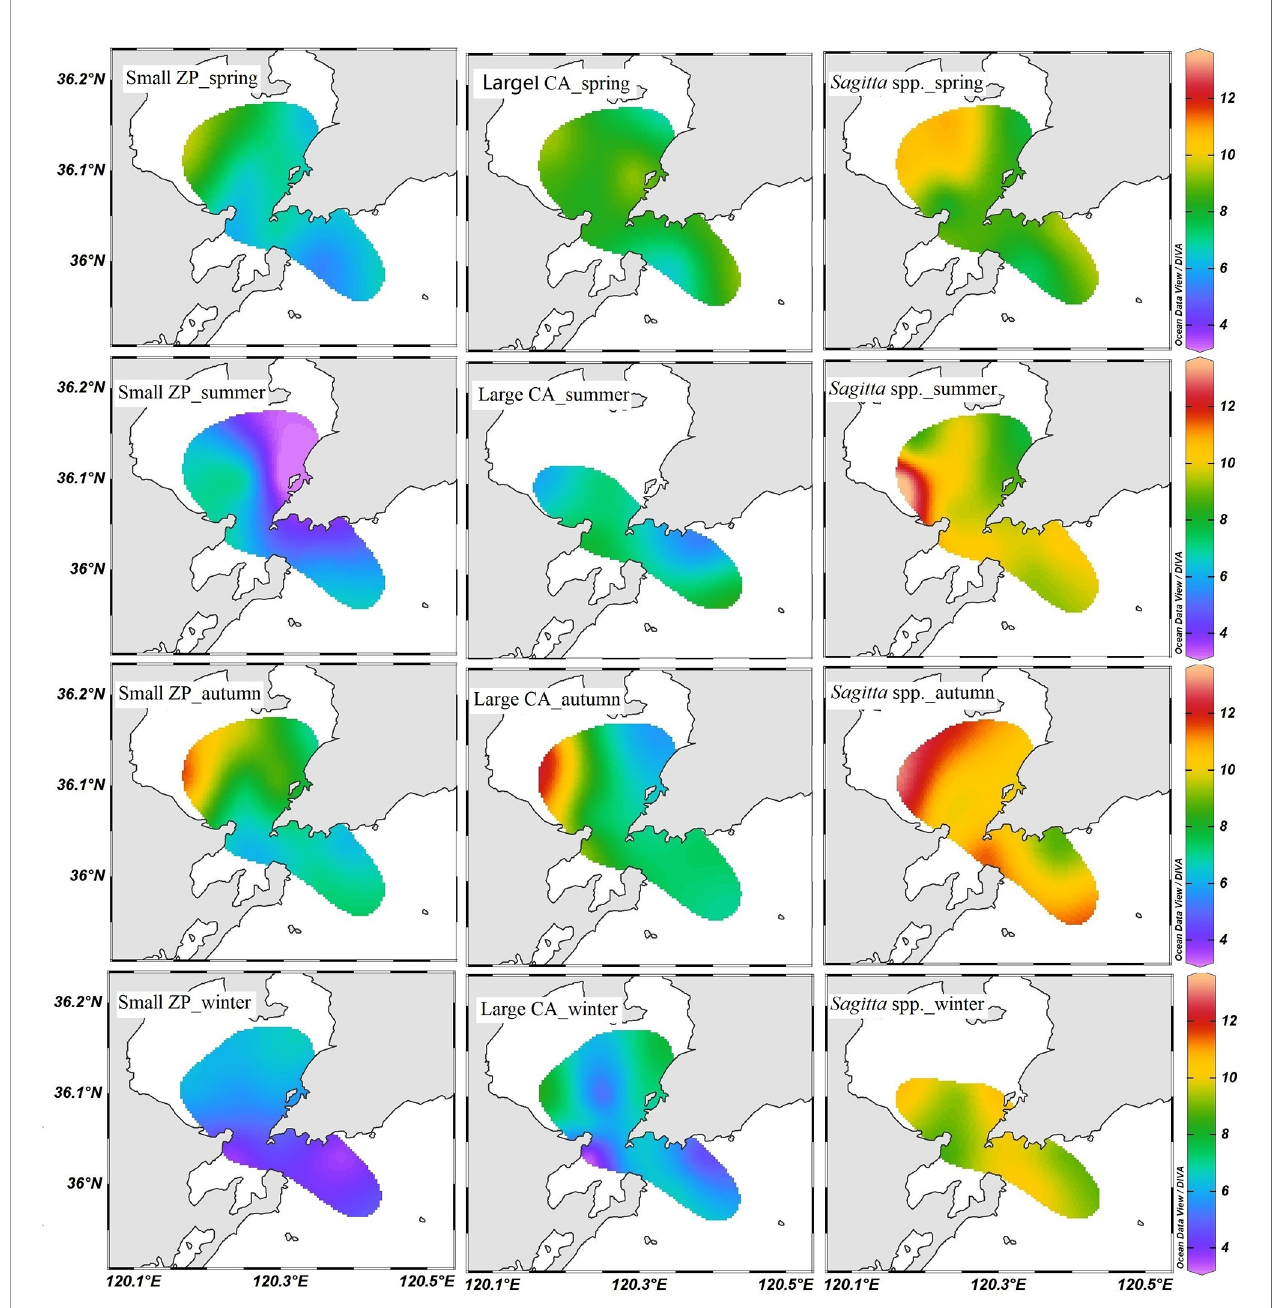
FIGURE 4 | Horizontal distribution of d 15 N in small zooplankton (small ZP), large calanoids (large CA), and Sagitta spp. in Jiaozhou